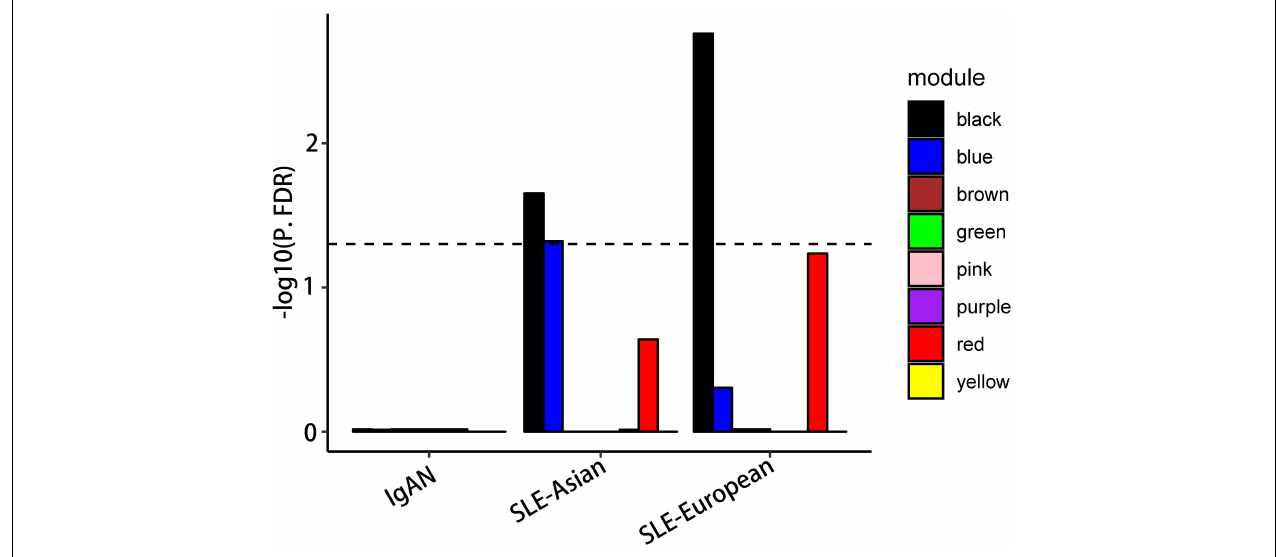
FIGURE 4 | Co-correlated modules’ GWAS enrichment. Significant blue module enrichment for LN associated variants from GWAS but not for systemic lupus erythematosus (SLE); no enrichment for